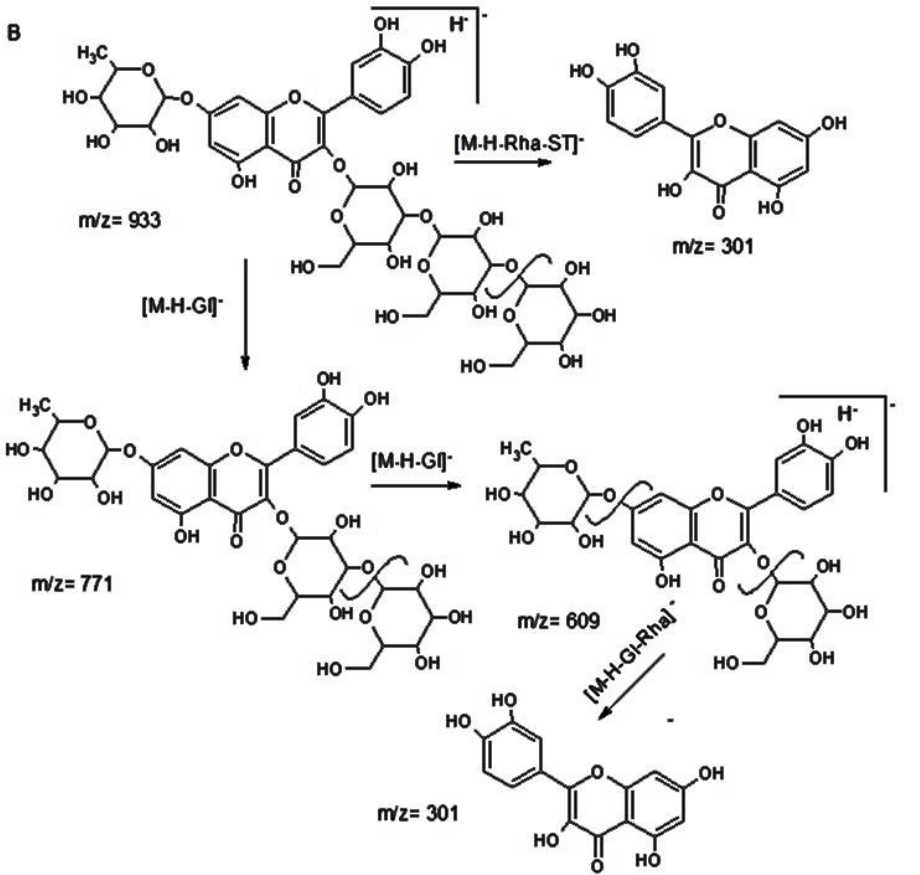
Figure 2. Hypothetic structures of selected daughter ions resulting from MS-MS fragmentation of the compound 6 epigallocatechin-epigallocatechin ( A ) and 15 quercetin-3-sophorotrioside-7-rhamnoside ( B ).